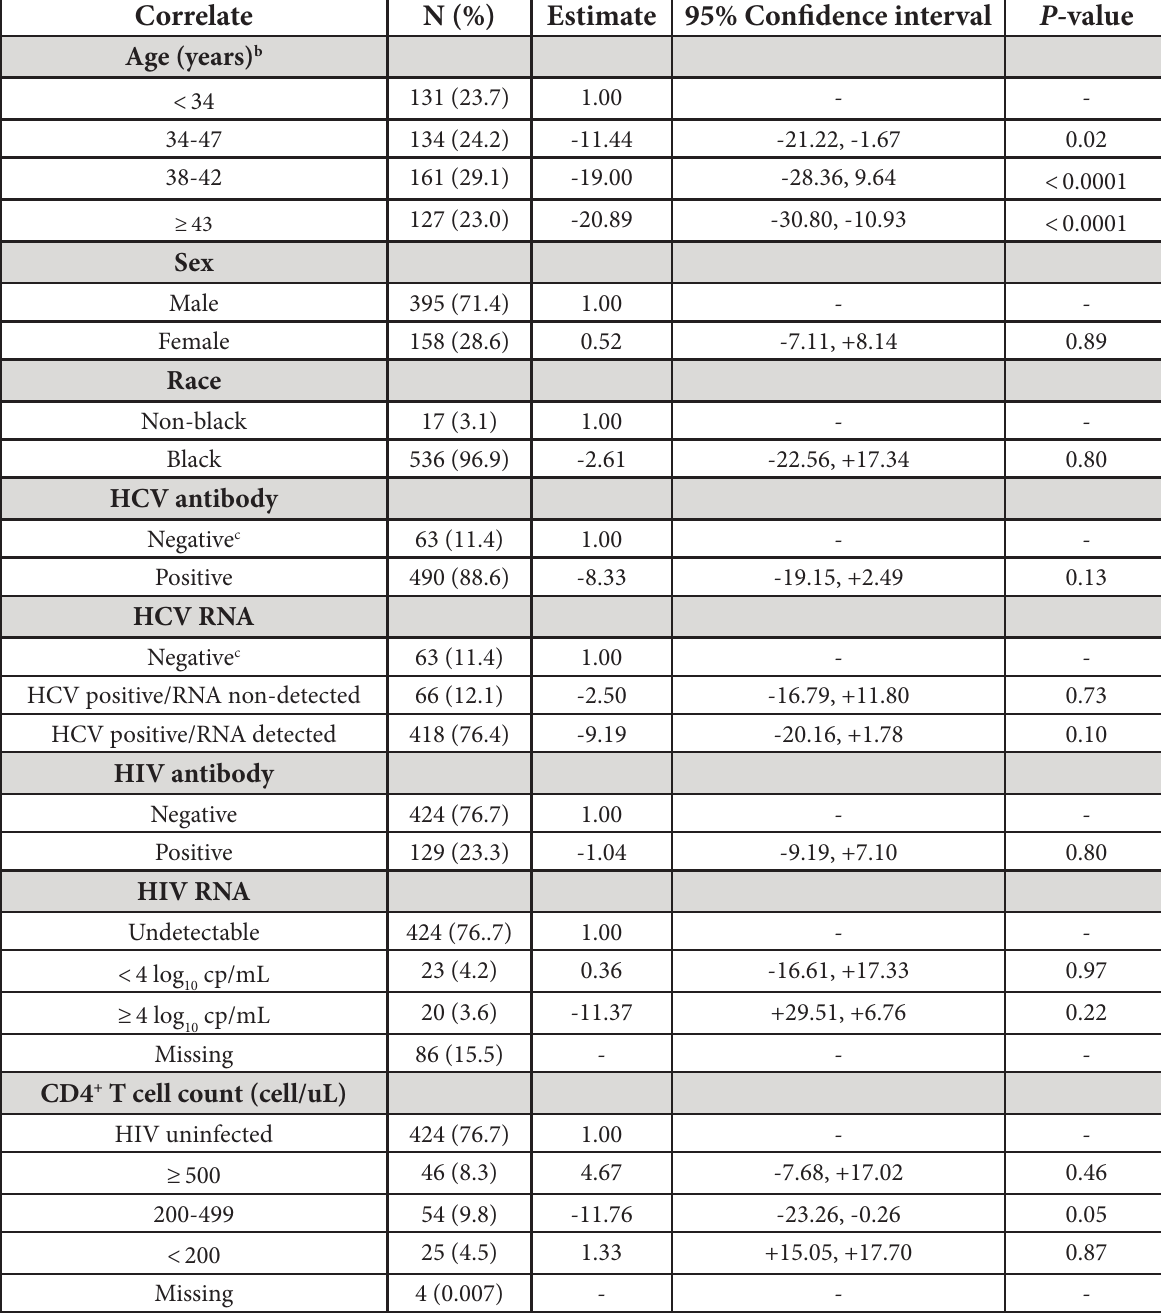
Table 1. Characteristics of the 553 study participants and baseline correlates of